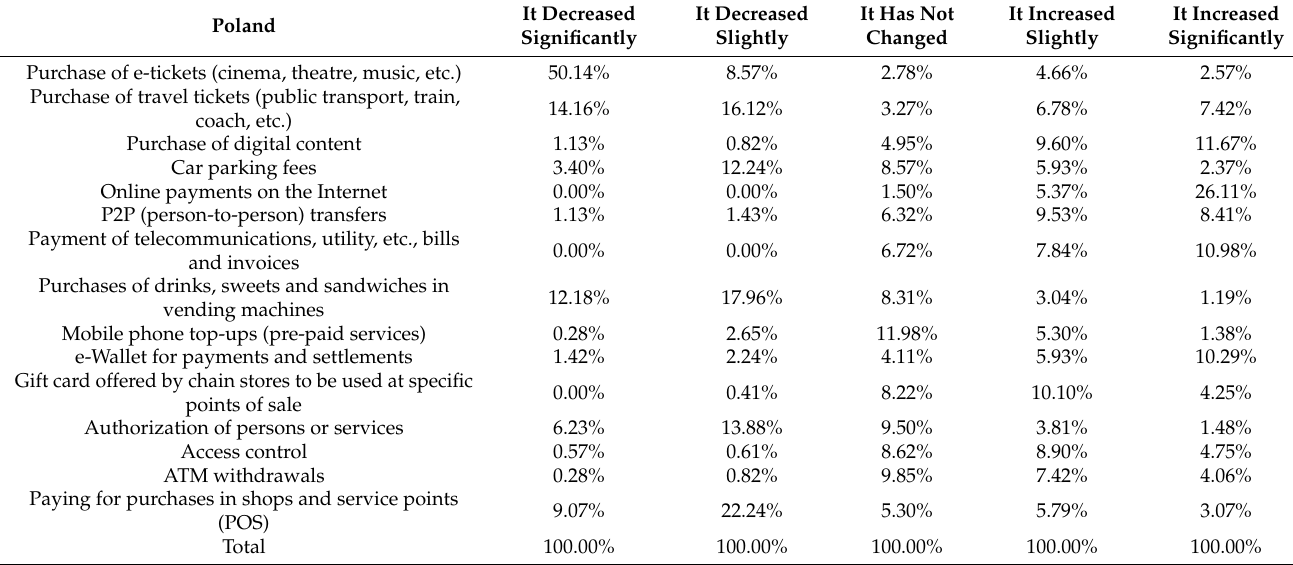
Figure 3. The advantages of choosing a bank’s website as a mobile payment tool; source: own work. Table 6. The dynamics of changes in mobile payments in Poland during the pandemic according to selected types of activity; source: own work.